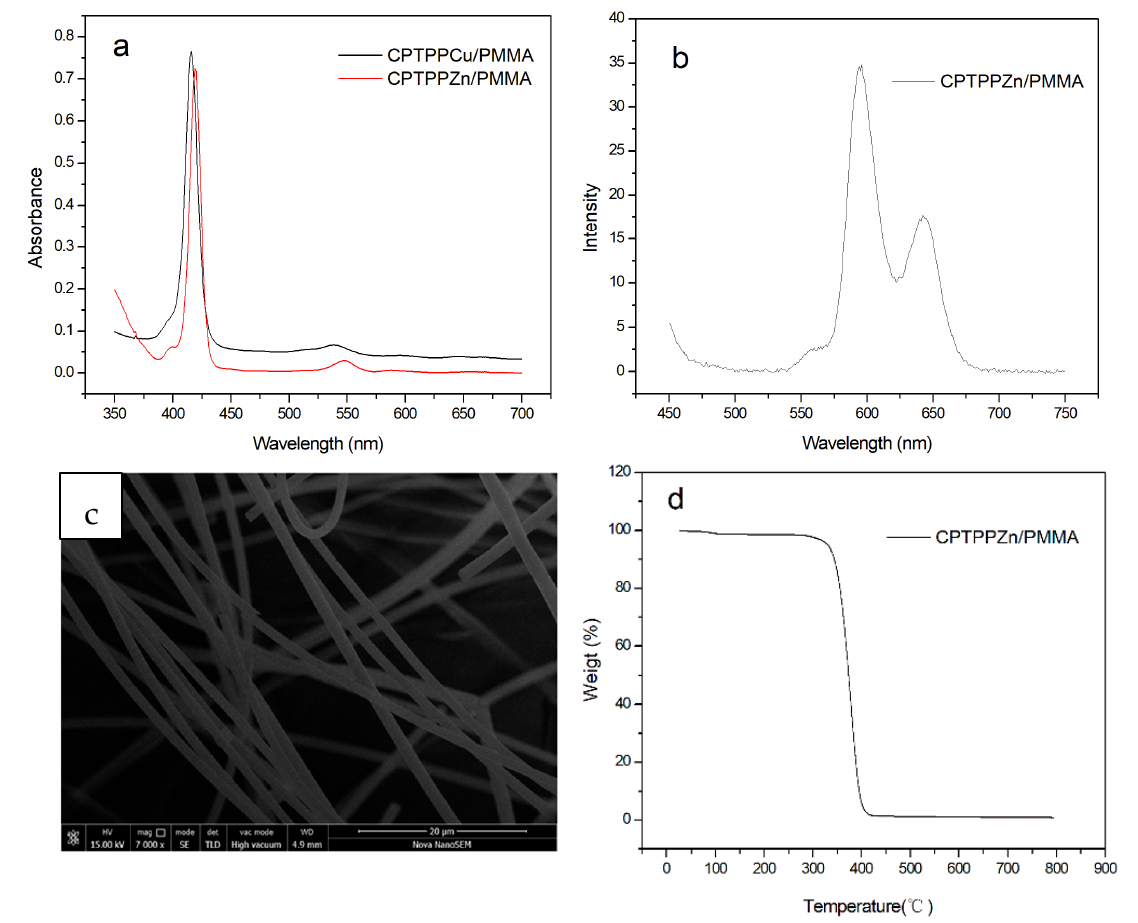
Figure 2. UV-Vis absorption spectrum ( a ), fluorescence emission spectrum ( b ), scanning electron microscope ( c ), and thermogravimetric curve ( d ) of metalloporphyrin/PMMA electrospun fiber.